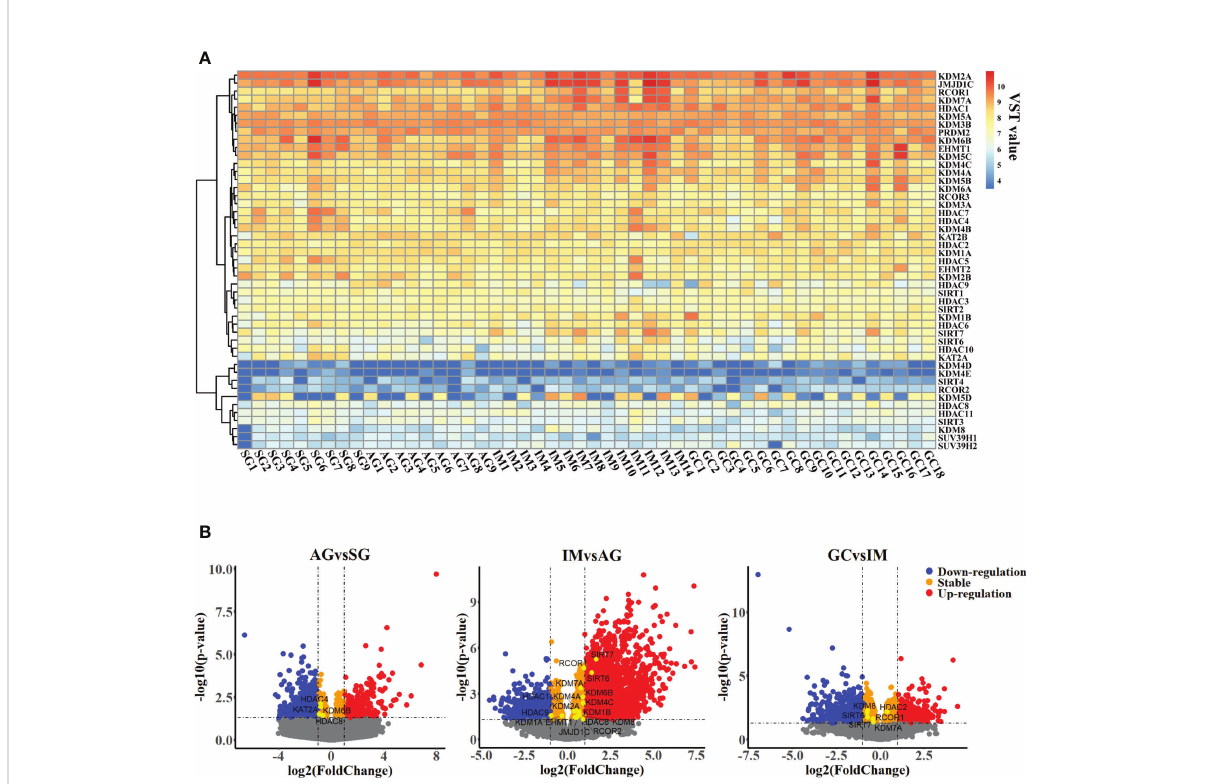
FIGURE 1 Transcriptomic pro fi les of gastric mucosa from patients suffering from chronic super fi cial gastritis, atrophy gastritis, intestinal metaplasia, and early gastric cancer. (A) Heatmap pro fi ling variance stabilizing transformed expression (VST value) of histone modi fi cation genes across samples. (B) Volcano plot illustrating differential genes between adjacent